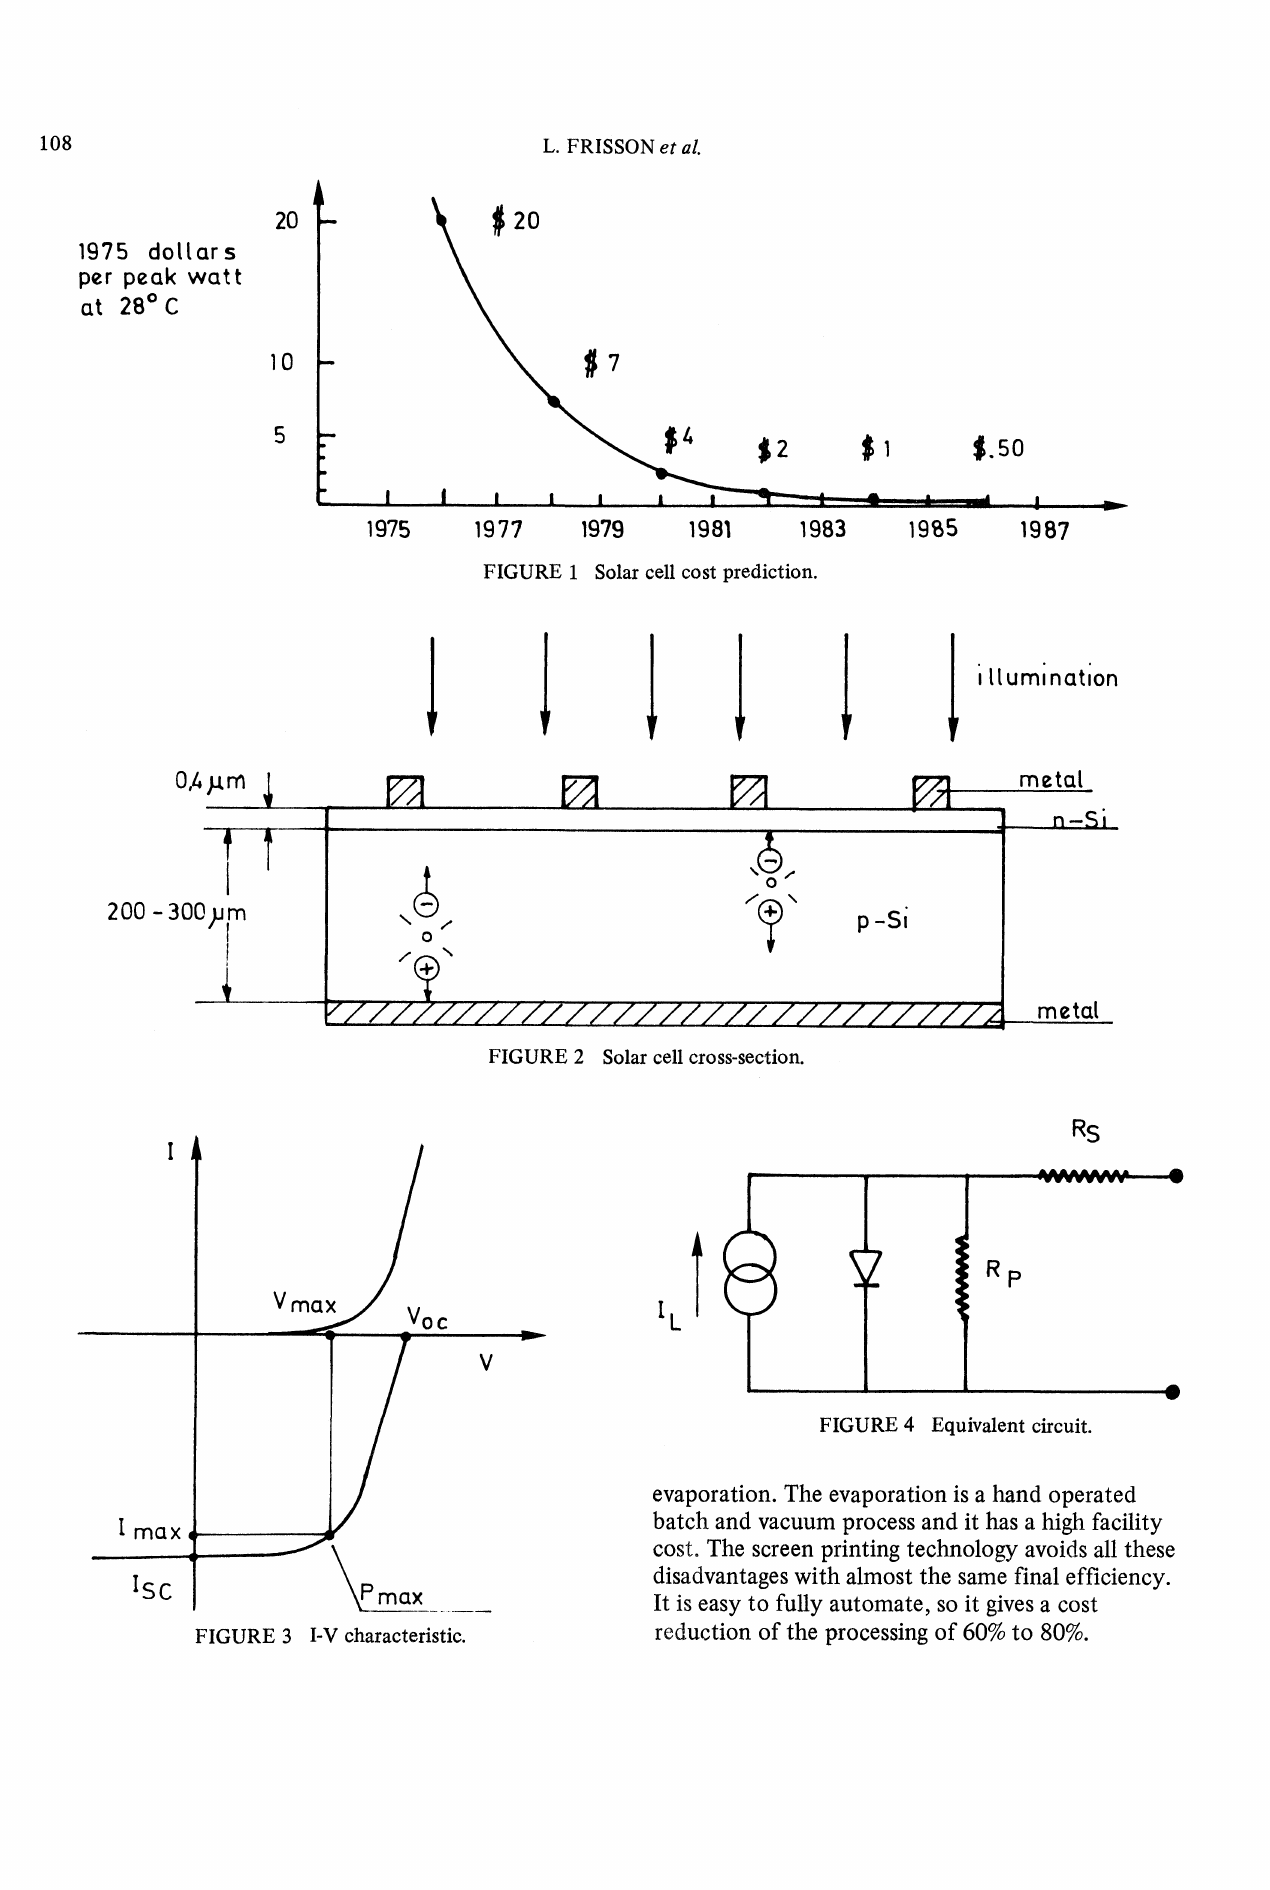
FIGURE 4 Equivalent